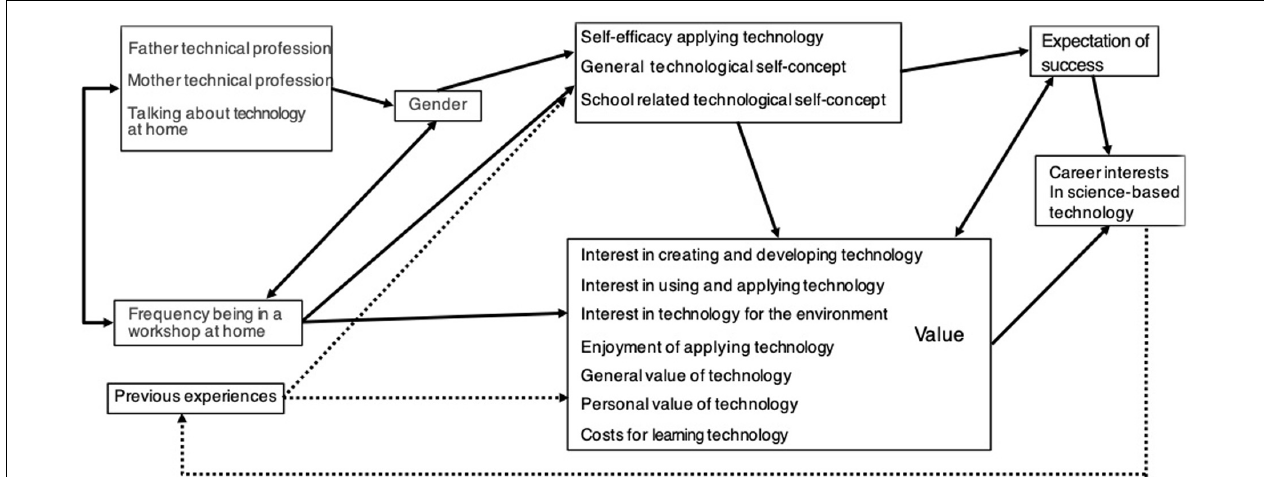
FIGURE 1 | Research model based on the expectancy-value model of Eccles and Wigfield (2002). Dotted lines indicate the associations that were not analyzed in this